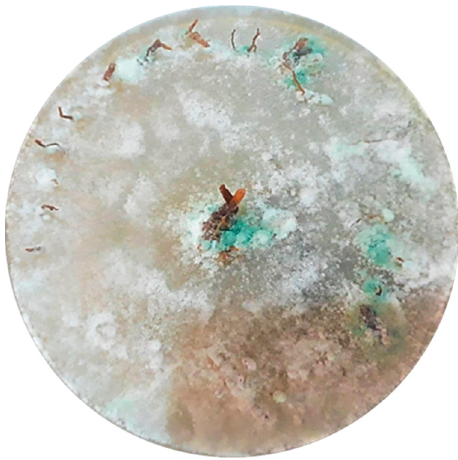
Figure 1. Mycelial growth of Trichoderma spp. and green sporulation on avocado and cinnamon roots on PDA